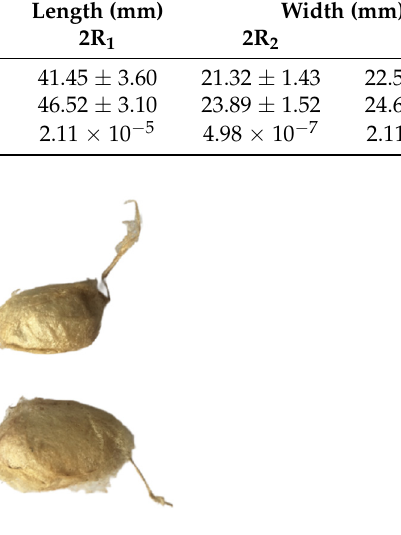
Figure 4. The comparison of the cocoons’ morphology. Table 1. Geometrical parameters of the A. pernyi cocoons from two different source regions (the error in this table is standard deviation).